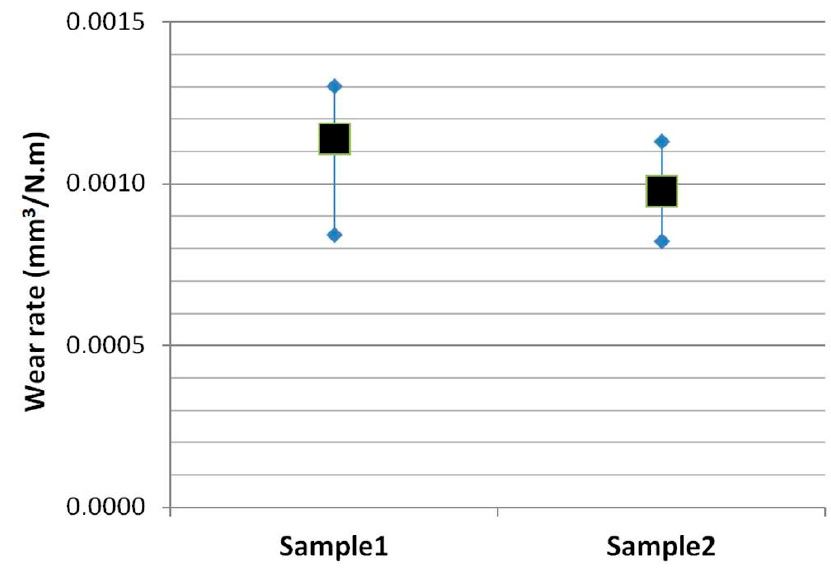
Figure 6. Wear rate obtained for the different heat treatment processes followed by samples of AISI A8 tool steel.